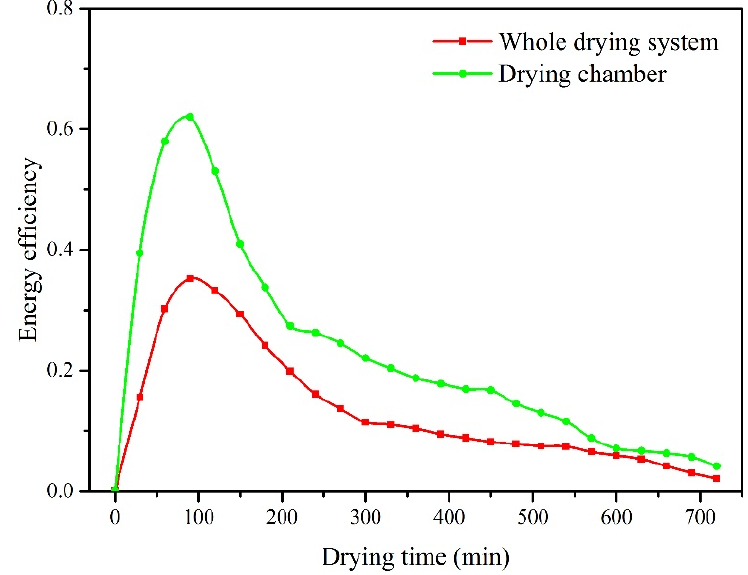
Figure 9. Variations of energy efficiency of the whole dryer and the DC during drying process.